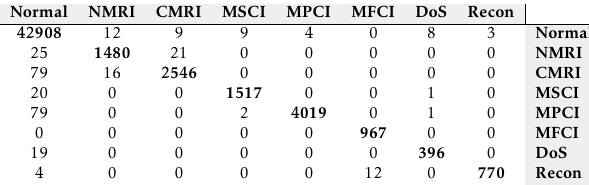
Table 9. Confusion matrix of the RF